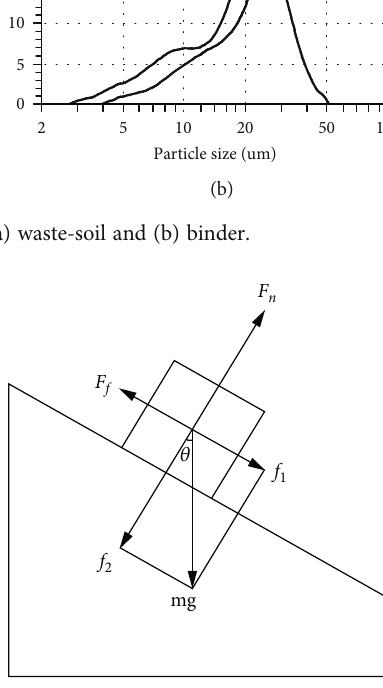
Figure 7: Sketch map of slope balance